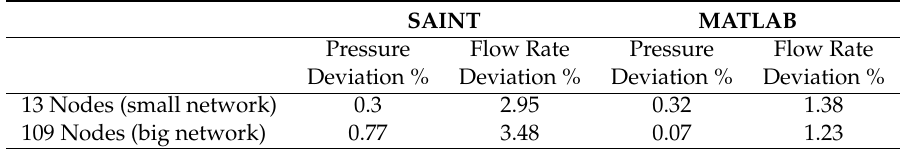
Table 5. Deviations of the novel method from the MATLAB and SAINT outputs.